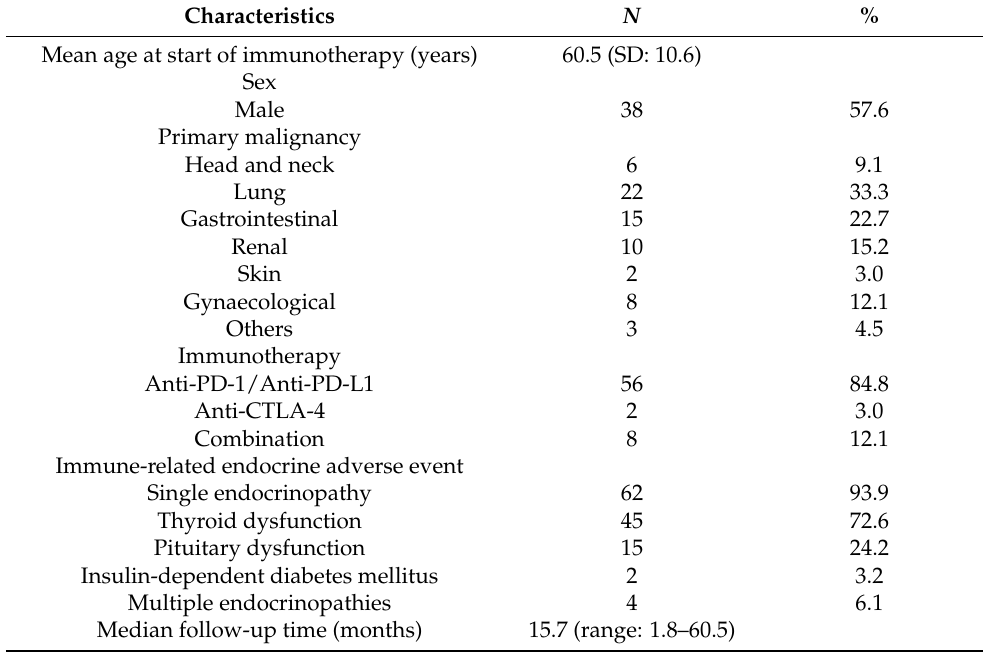
Table 1. Baseline characteristics of study cohort ( n = 66).